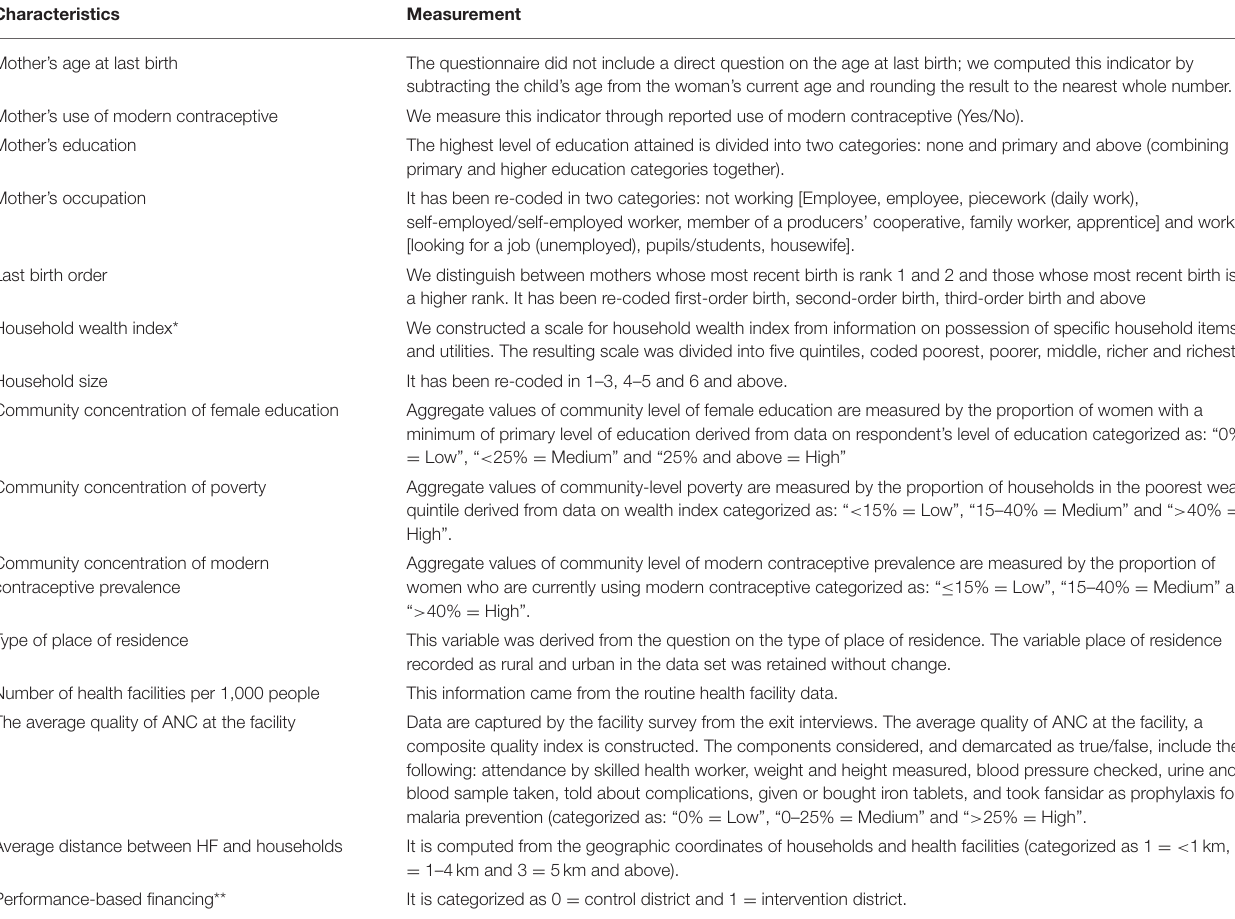
TABLE 1 | Measurement of explanatory variables included in the estimated models. Characteristics